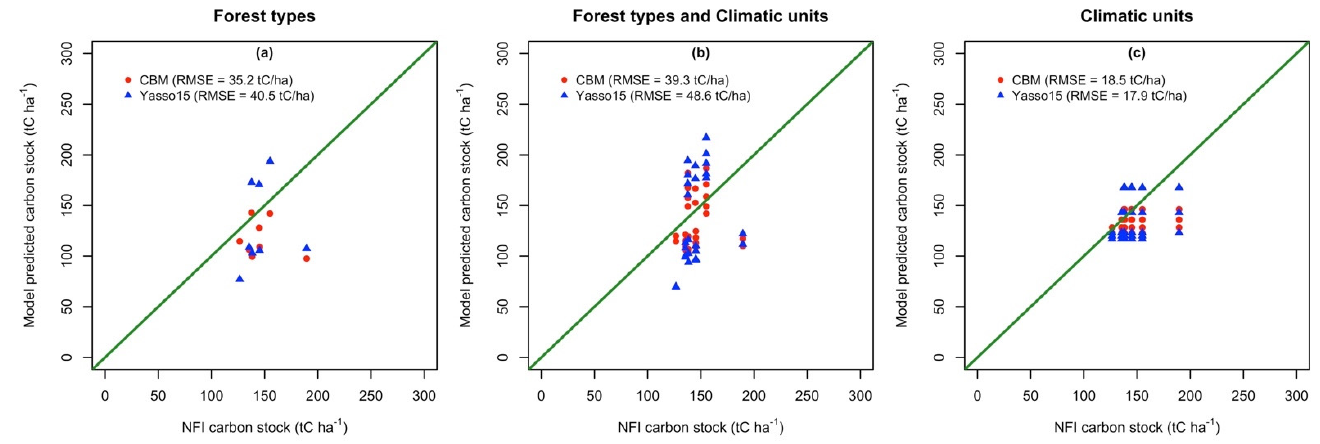
Figure 5. Measured and modeled C stock when the data is pooled on forest type ( a ), forest type and CLU ( b ), and CLU alone ( c ). Yasso15 is denoted with blue and CBM with red color. Green line represents 1:1 value on the OX and OY axes.